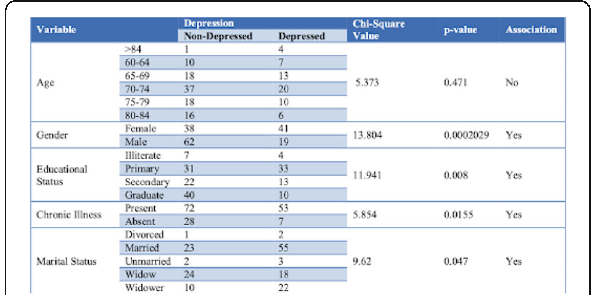
Fig. 1 (abstract P0486). See text for description